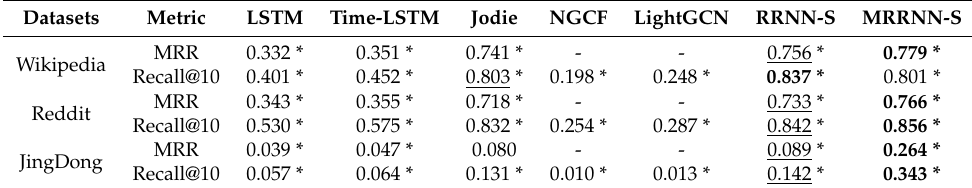
Table 3. Overall performance w.r.t. Recall@10 and MRR. “*” indicates the improvement of the MRRNN-S over the baseline is significant at the level of